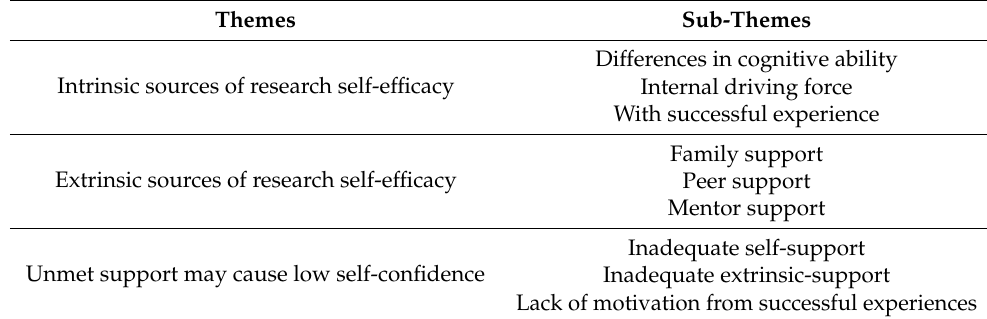
Table 3. Themes and